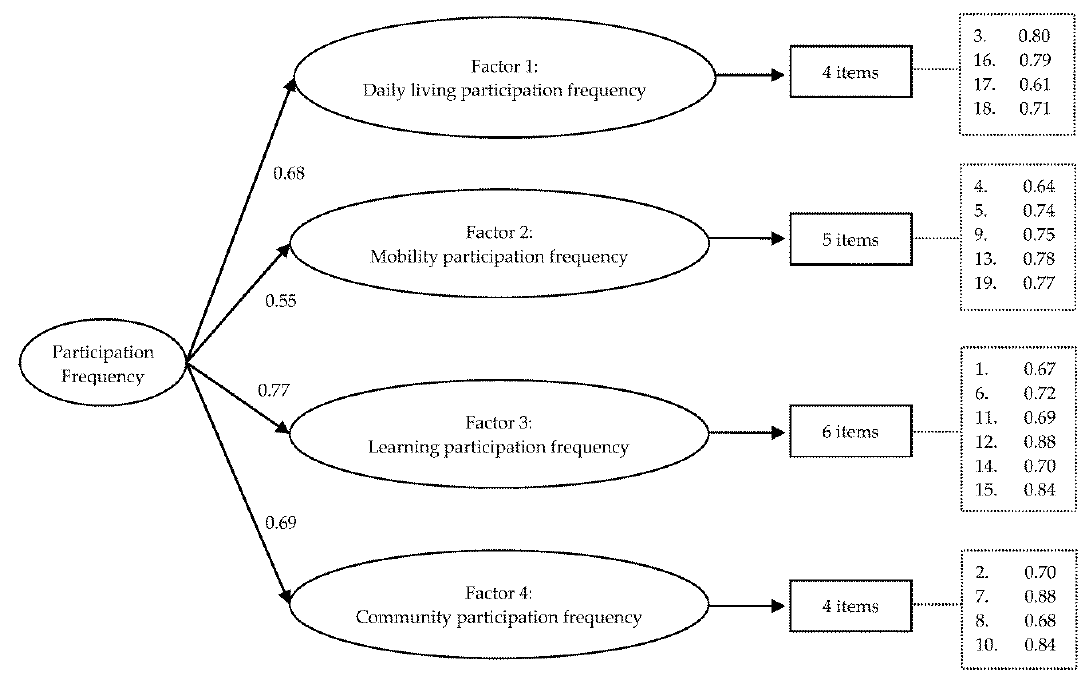
Figure 1. Second-order confirmatory factor analysis model of the frequency dimension of the participation part of the Functioning Disability Evaluation Scale-Child version ( n = 4823).